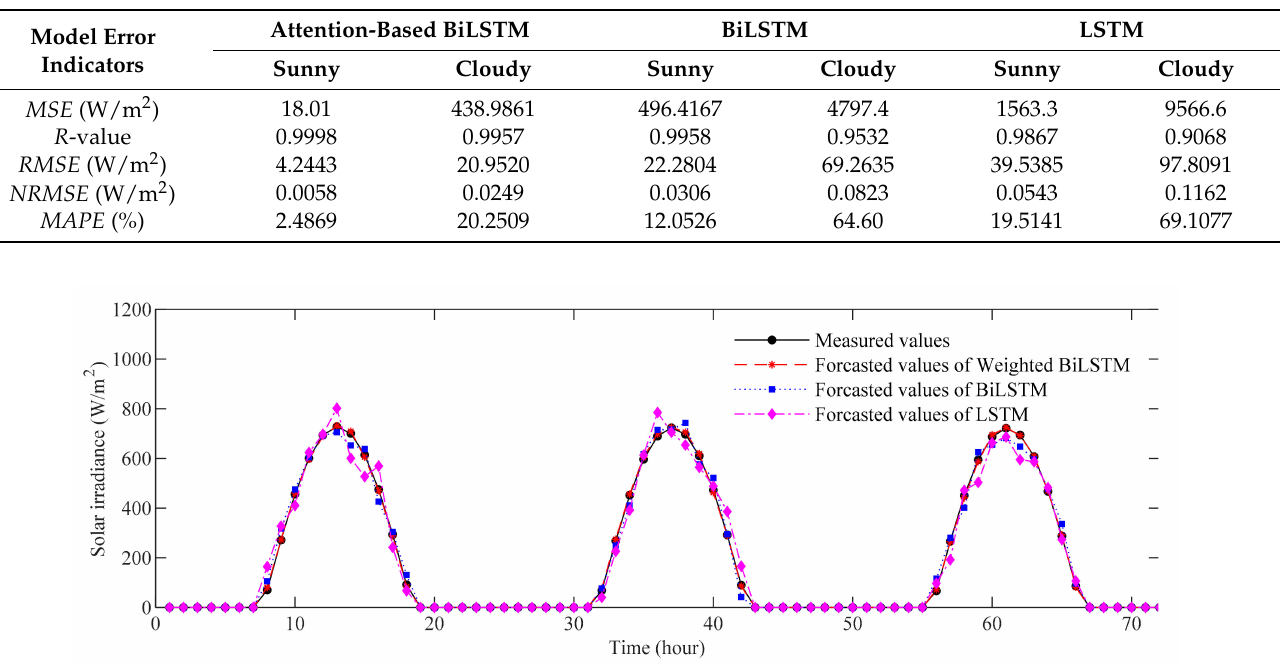
Table 1. Statistical indicators of error for forecast models developed.